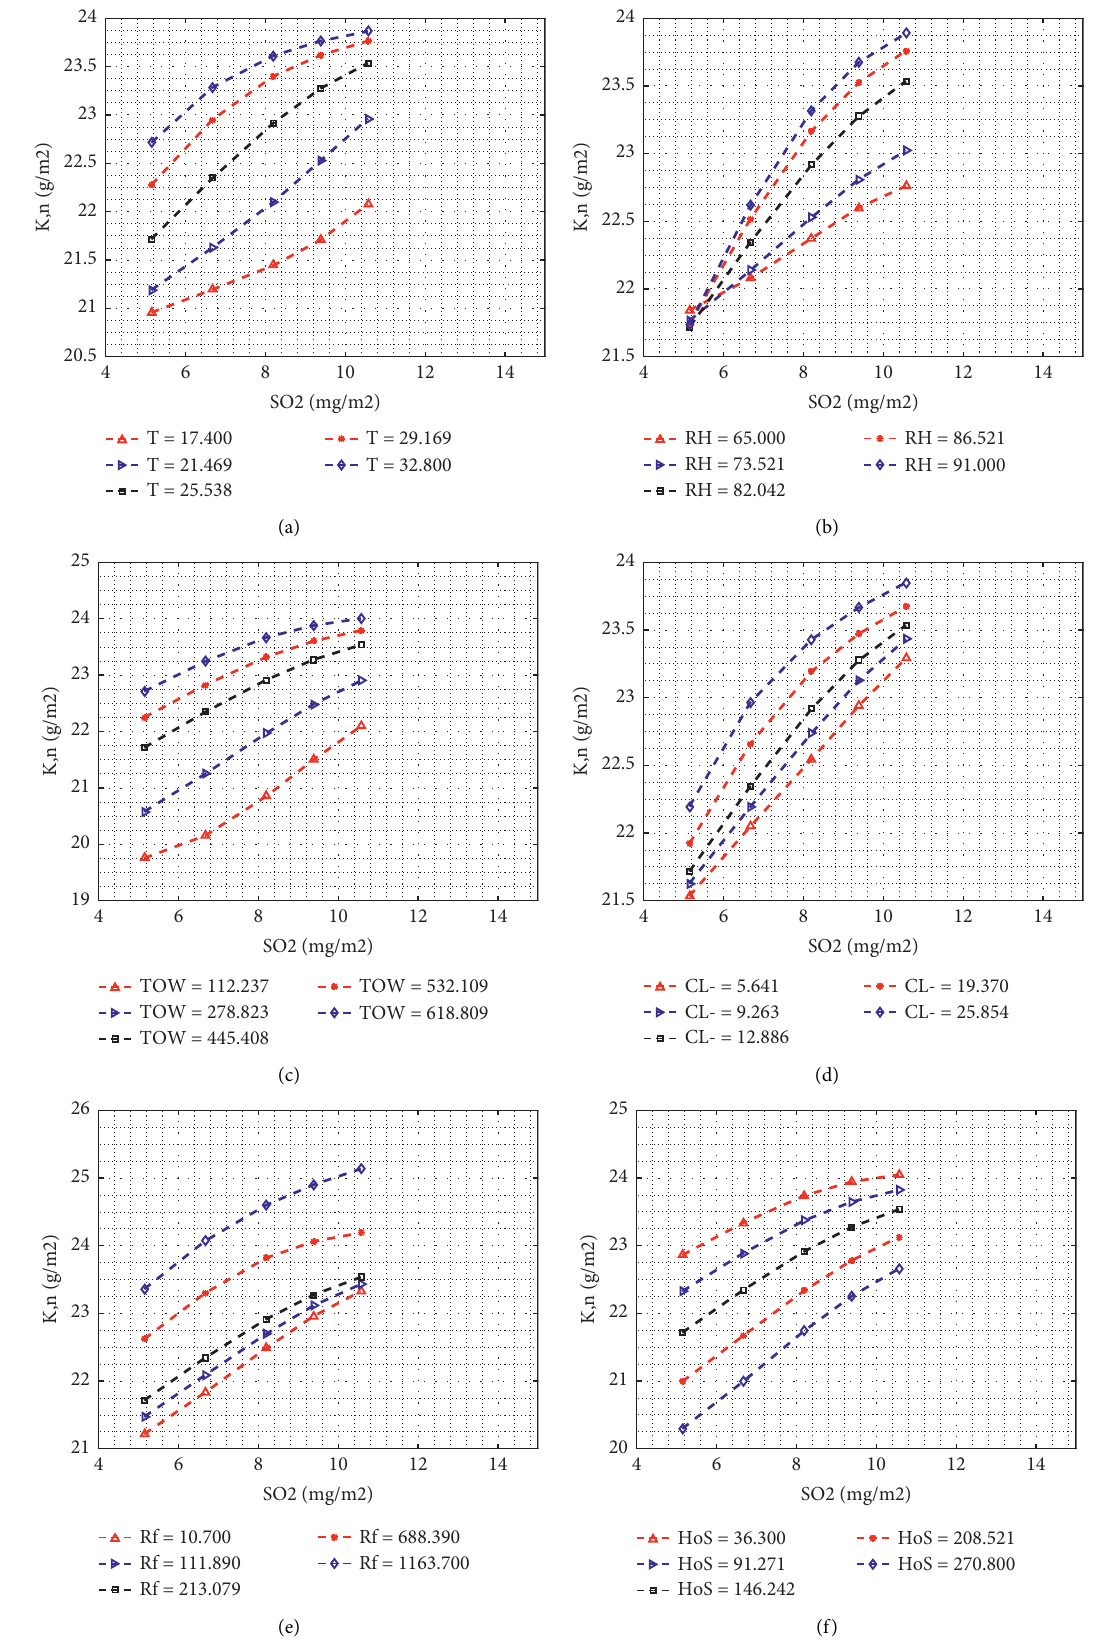
Figure 17: Effect of the average sulfur dioxide deposition